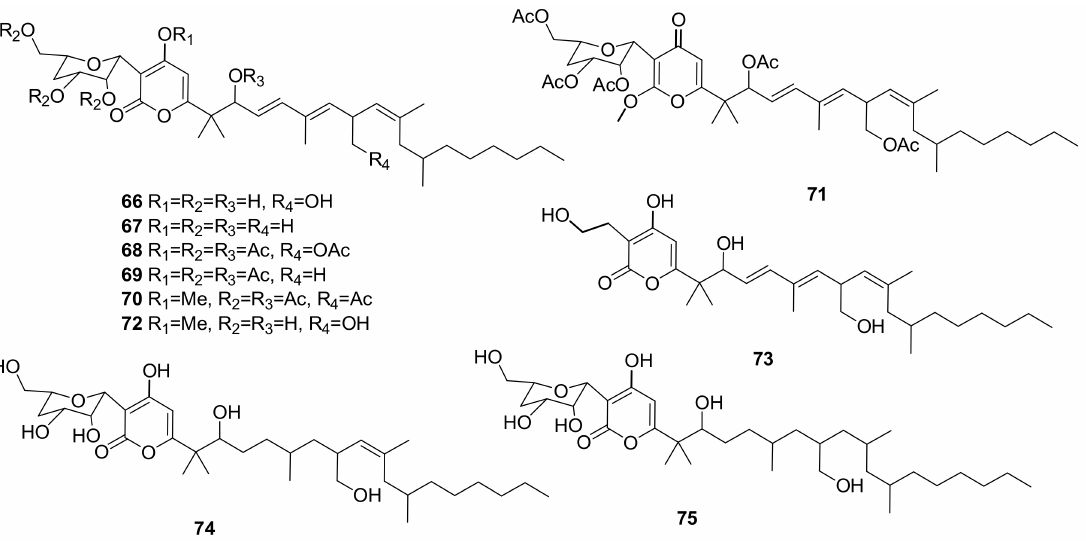
Figure 5. The structures of fusapyrone ( 66 ), its derivatives ( 68 , 70 – 75 ), deoxyfusapyrone ( 67 ), and its derivative ( 69 ).